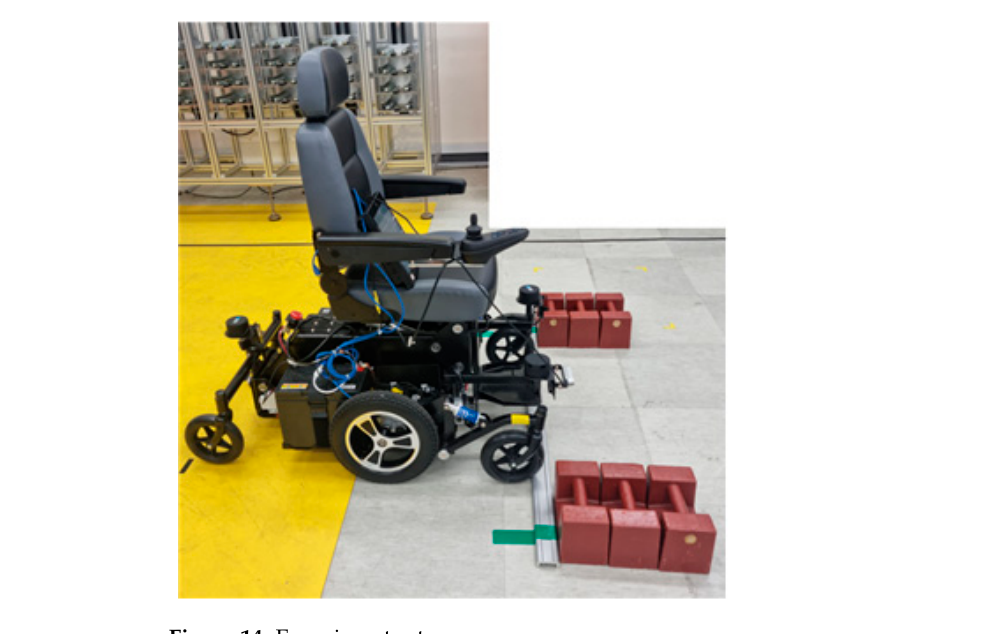
Figure 16. Experiment for autonomous driving on the path (S: start point, O: obstacle, and E: end point). To validate the effectiveness of the autonomous driving function of the wheelchair, it was driven on the same path using two methods: autonomously (no one was on the wheelchair) and manually (a person sitting in the wheelchair and maneuvering it). Under the premise that accidents, such as hitting an obstacle, did not occur, the efficiency was set to be higher as the robot drove closer to the straight line between the starting and end